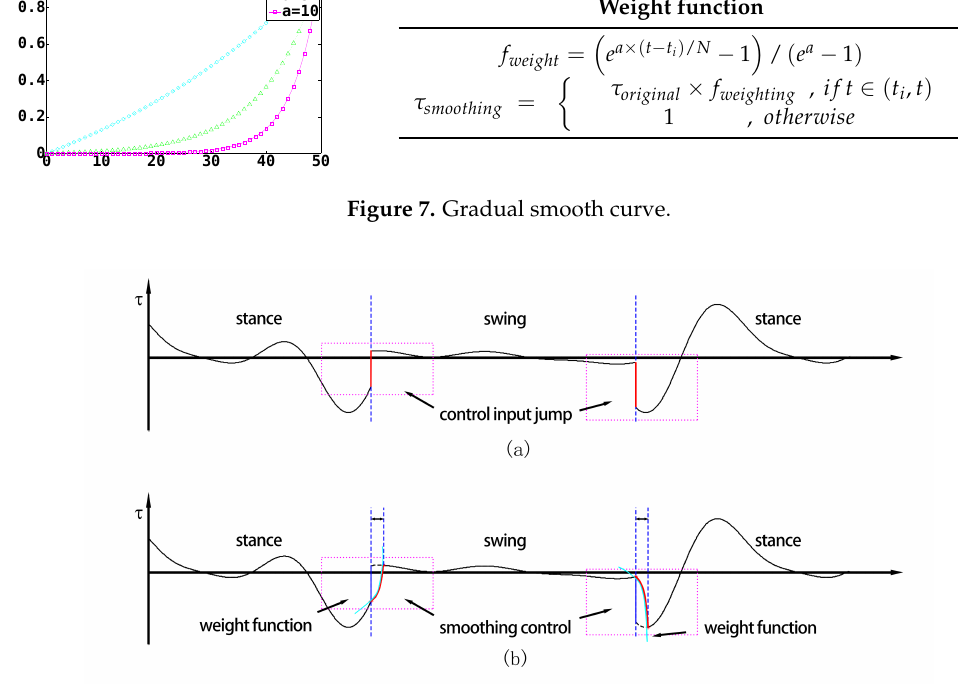
Figure 8. The effect of the smoothing method in the pre-conversion process: ( a ) shows the control input jump when switching; ( b ) avoids the sudden-jump of the control input by smoothing method, this has practical application value for pneumatic